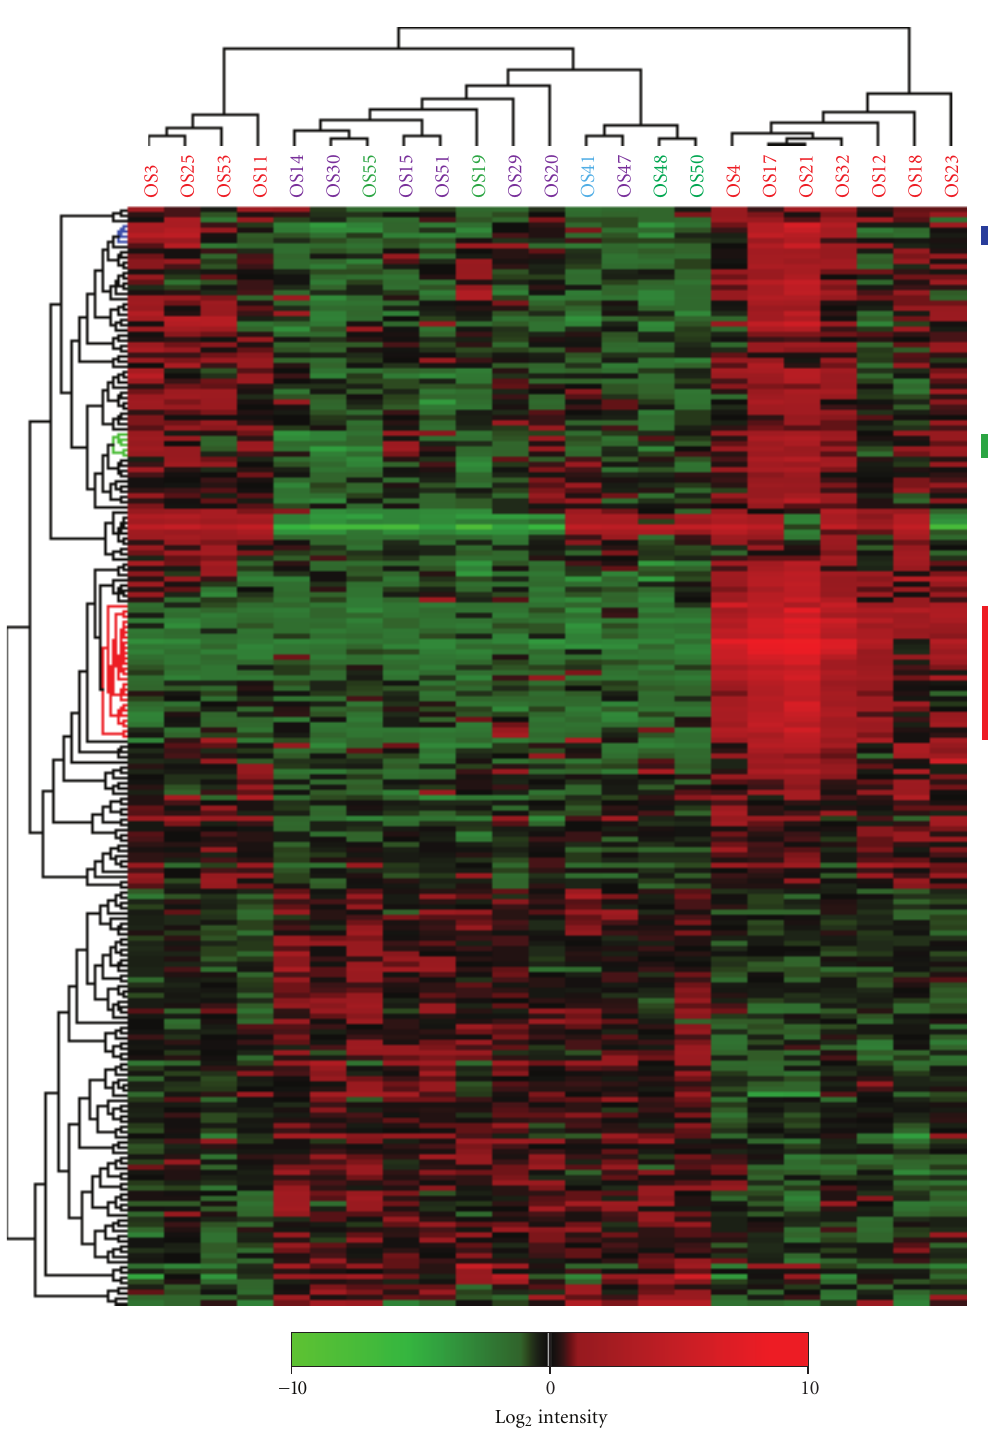
Figure 1: Hierarchical clustering of all tumours based on the top-210 significant genes di ff erentially expressed between metastases and primary tumours, identified by SAM analysis. Samples coloured in red, metastases; lilac, primary samples from patients who later developed metastases; green, primary samples from patients who did not develop metastases blue, clinical information on metastases not available. Gene cluster coloured in blue, CXCL1, -2 , - 3 , IL6, and LOC131873 ; green, EGR1 , - 2 , FOSB , FOS, and JUNB ; red, surfactant genes. Red, increased gene expression; green, decreased gene expression. The cluster was made using average linkage and Pearson’s